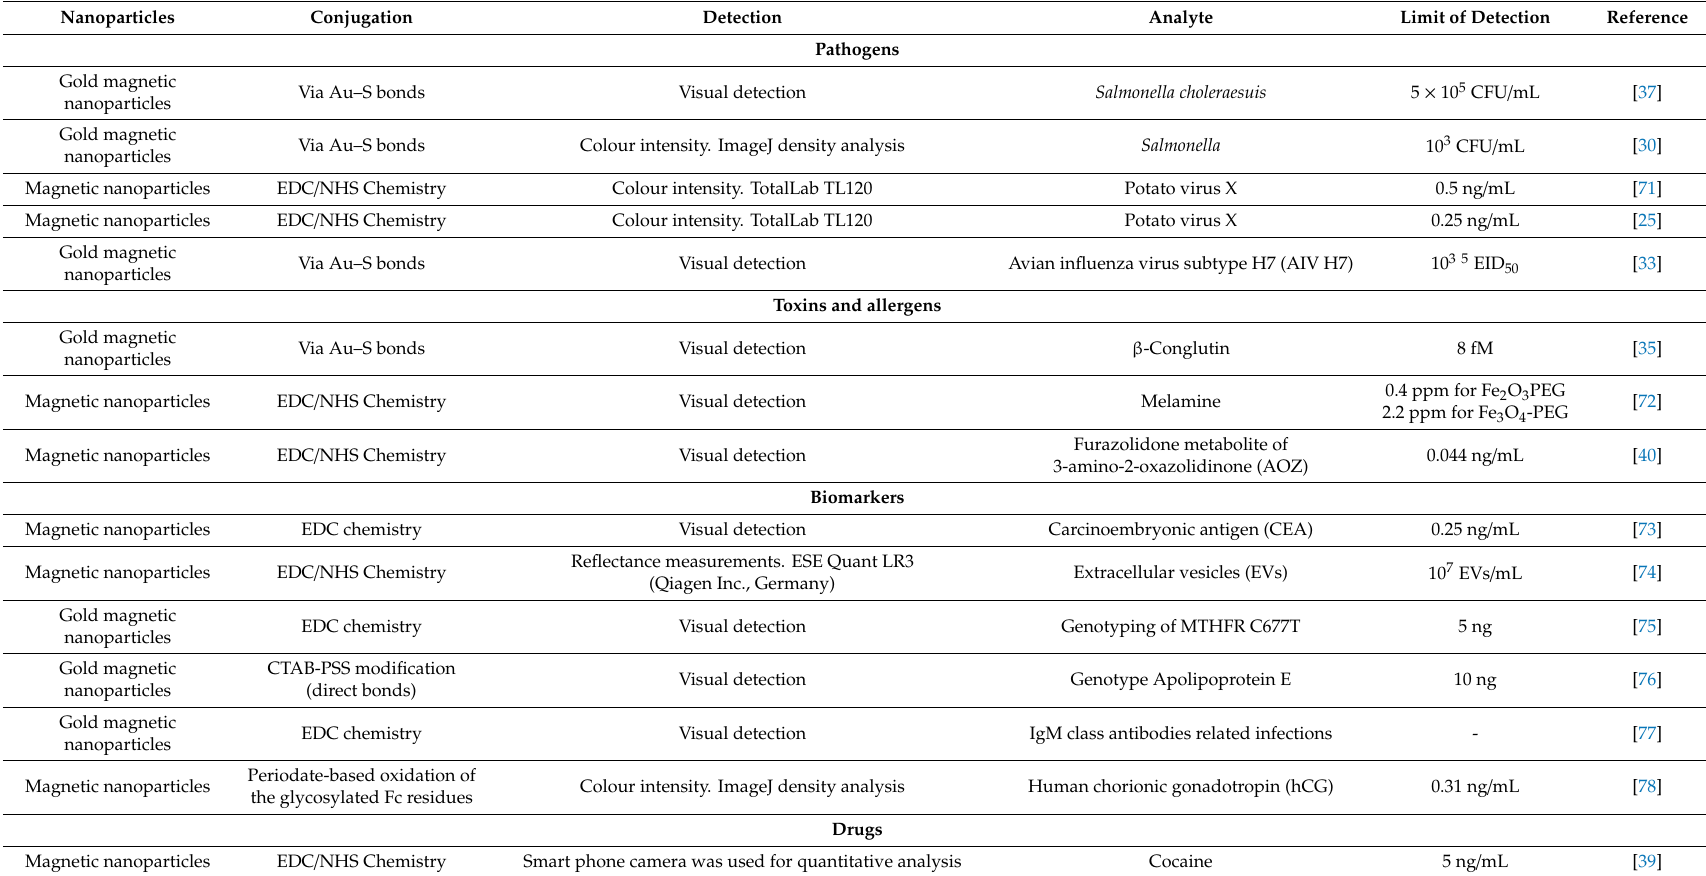
Table 3. Most recent Magnetic LFIA with optical